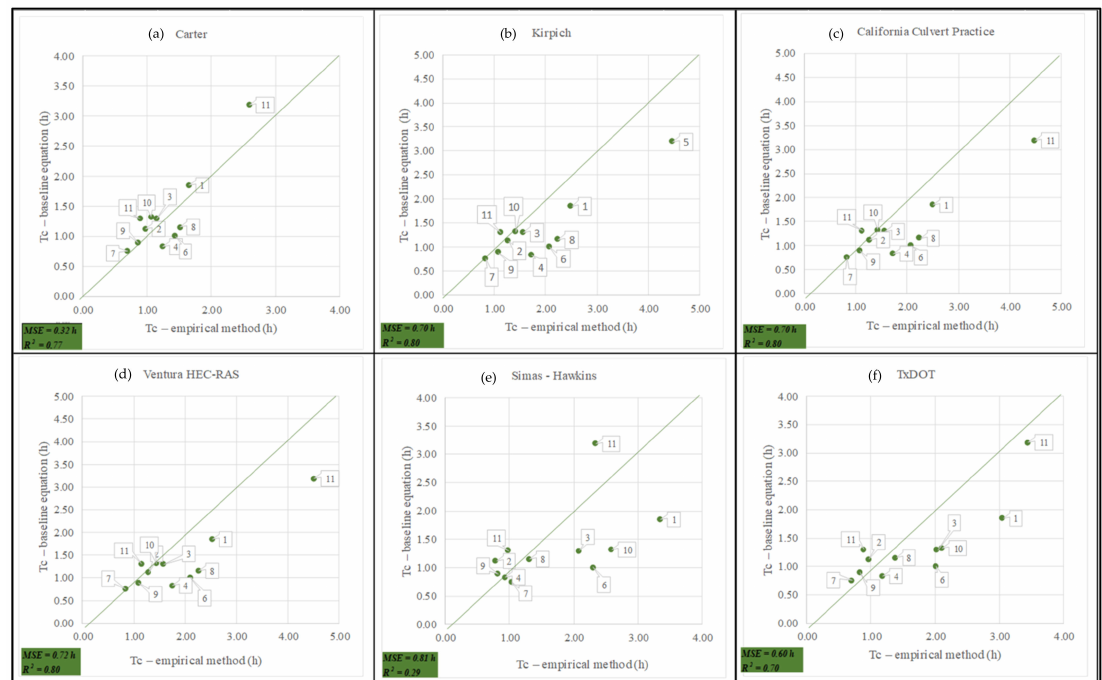
Figure 6. Tc graphs estimated with empirical methods versus Tc calculated with the baseline equation: ( a ) Carter; ( b ) Kirpich; ( c ) California Culvert Practice; ( d ) Ventura; ( e ) Simas-Hawkins; and ( f )